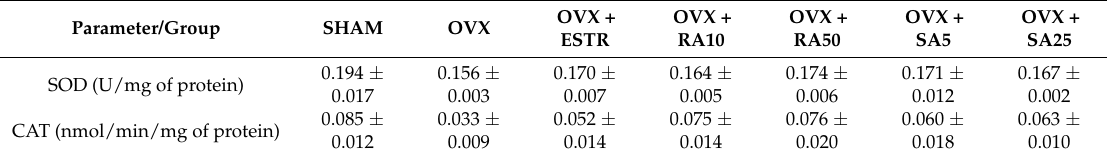
Table 2. Effect of rosmarinic acid and sinapic acid on the superoxide dismutase (SOD) and catalase (CAT) activities in the lenses of ovariectomized rats.